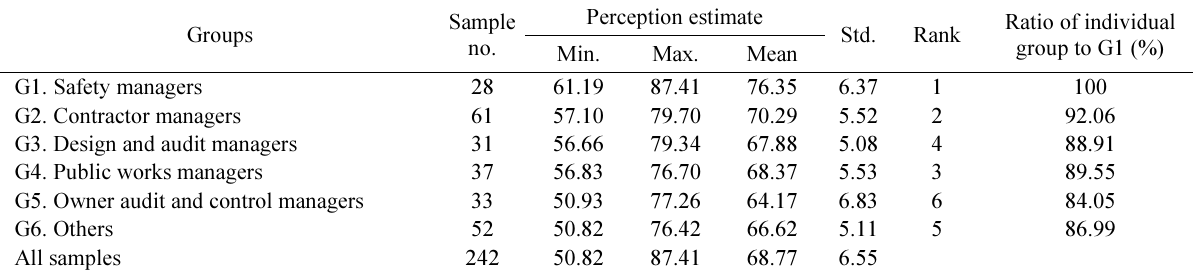
Table 9. Questionnaire perception estimate of group ranking